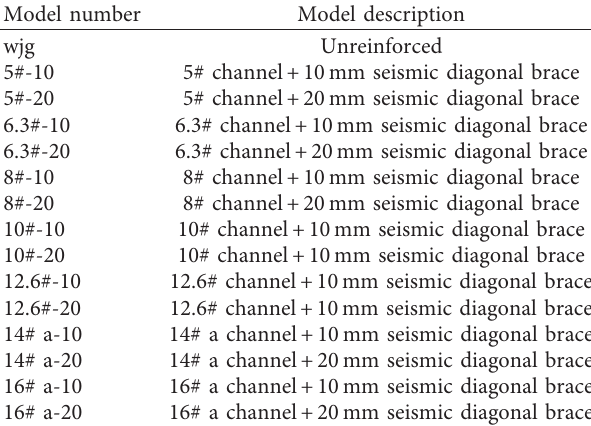
Figure 18: Skeleton curves of group B